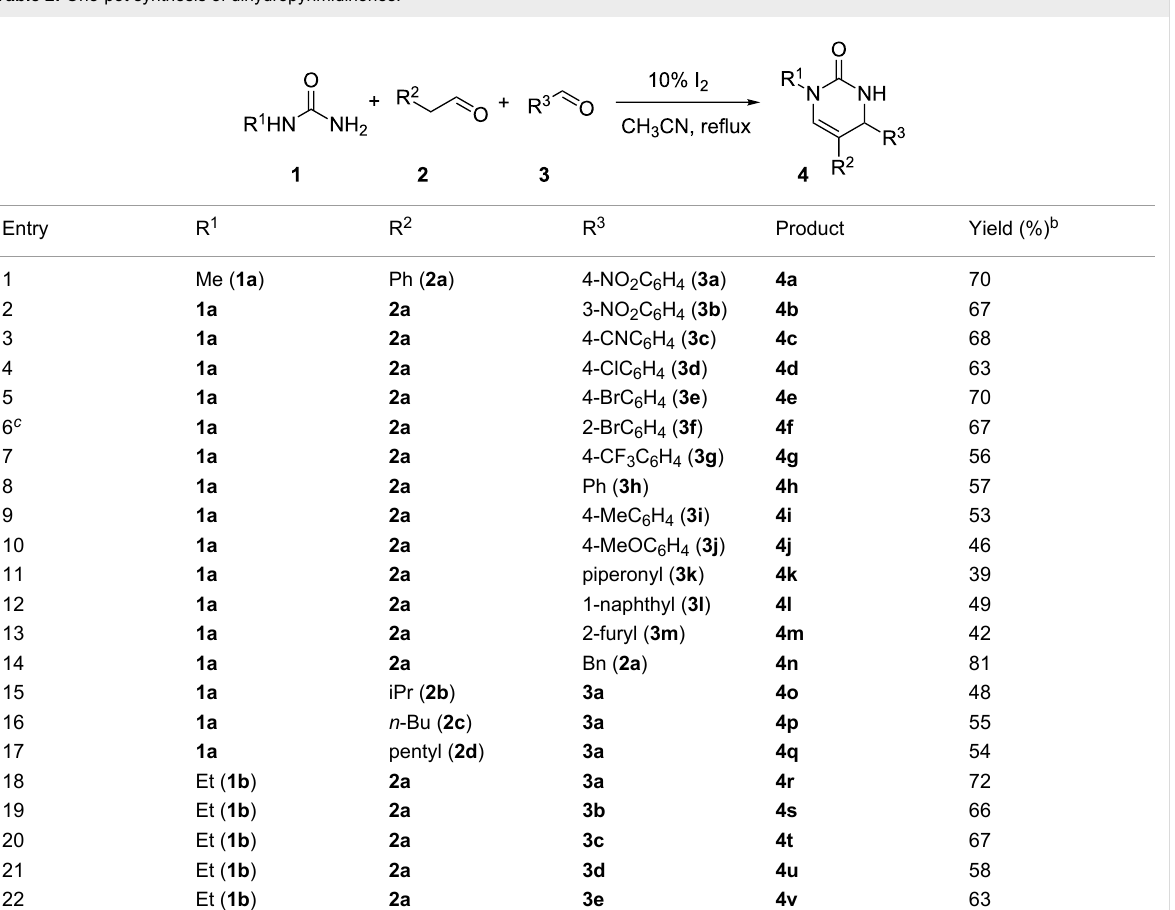
Table 2: One-pot synthesis of dihydropyrimidinones.